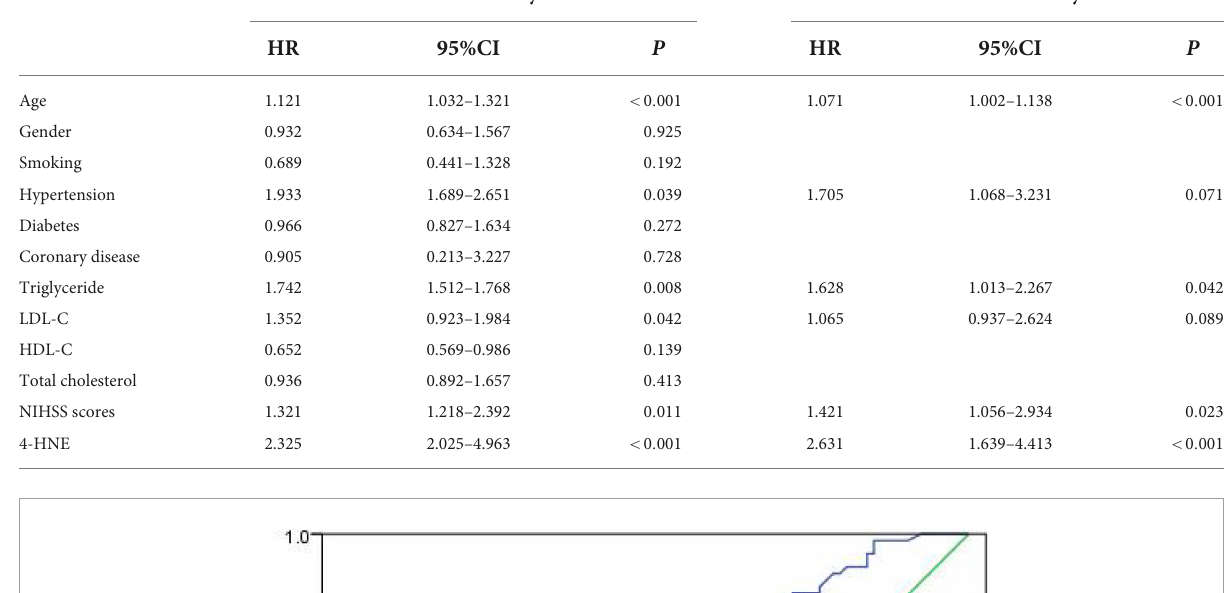
TABLE 3 Multivariate Cox regression results of influencing factors for recurrent cerebral infarction.